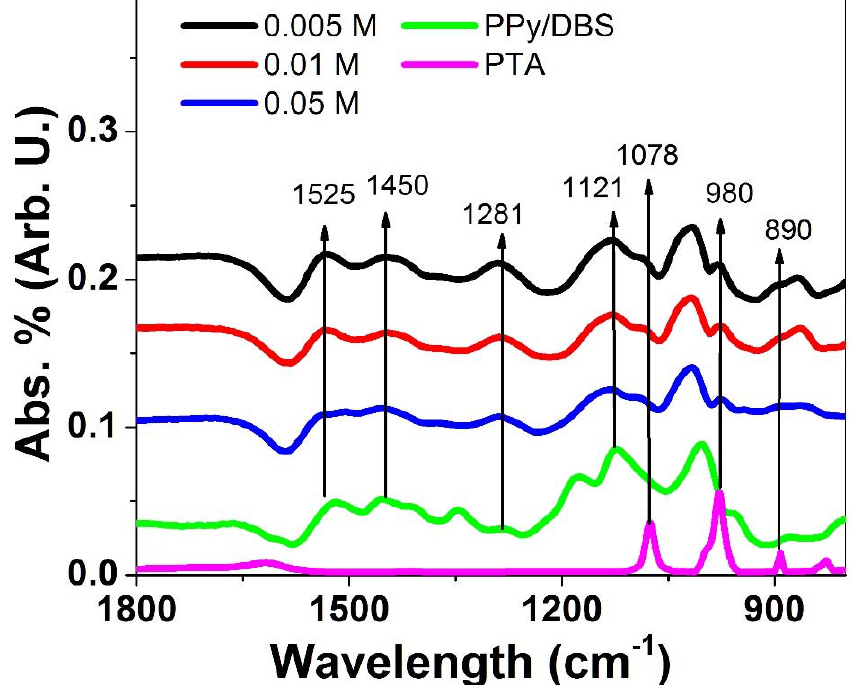
Figure 2. FTIR spectroscopy (1800–800 cm − 1 ) of PPy/DBS-PT films with PTA concentrations of 0.005 M (black line), 0.01 M (red line), and 0.05 M (blue line) compared to pristine PPy/DBS (green line) and PTA (pink line).